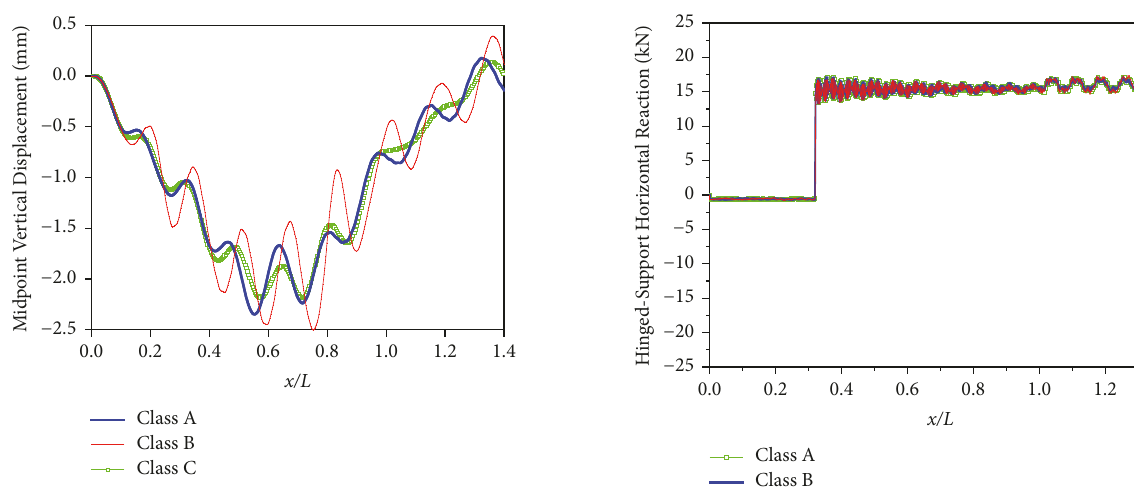
Figure 14: Vertical displacement of midpoint of simply supported beam with different roughness class.